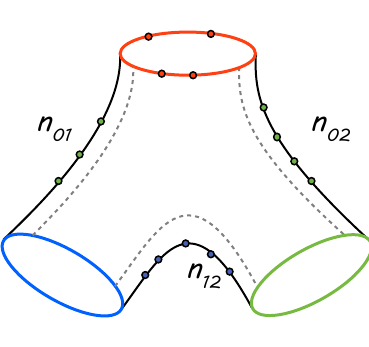
Figure 1 . The asymptotic three point function should be suplemented with (cid:12)nite size corrections from the three mirror edges. Following the procedure from [7] one is instructed to insert resolution of the identity in each of the edges. The states can have any number of particles on them however the higher the particle number the more surpressed the contribution